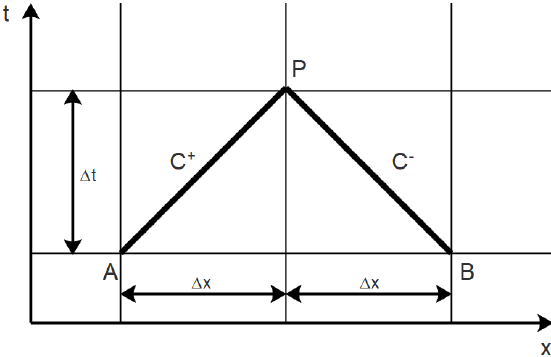
Figure 1. Characteristic lines in the x - t